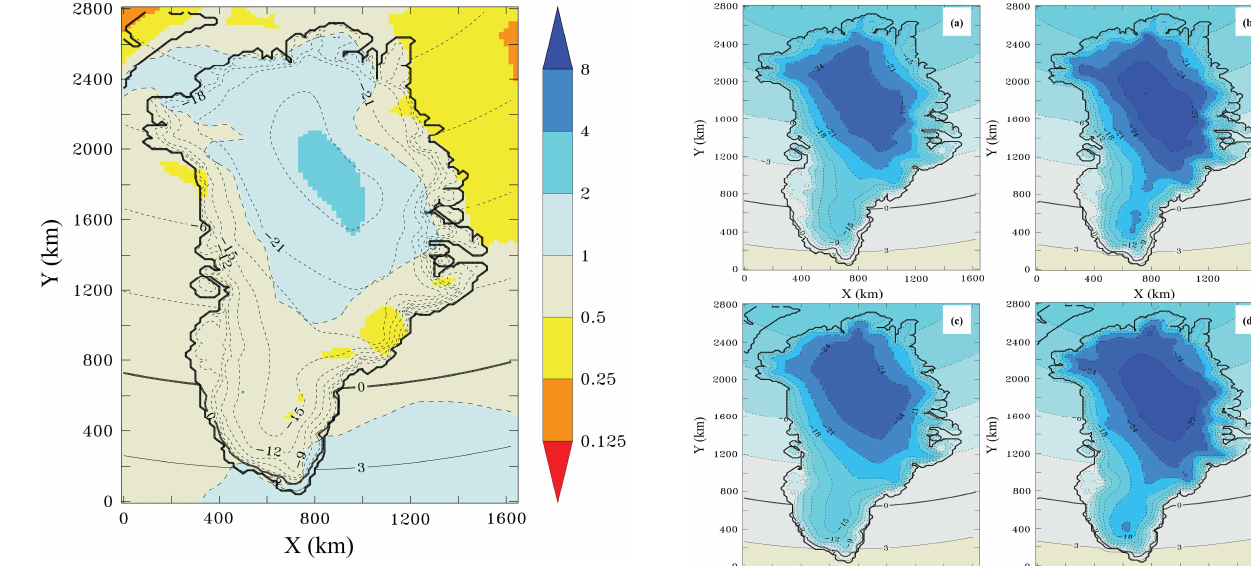
Figure 3. Change in precipitation over Greenland between EISMINT-3 (Ohmura and 2 Fig. 3. Change in precipitation over Greenland between EISMINT- Reeh, 1991) and ERA-40 re-analysis (Uppala et al. 2005) expressed as a ratio of 3 3 (Ohmura and Reeh, 1991) and ERA-40 re-analysis (Uppala et EISMINT-3:ERA-40. Annual near-surface temperature (in °C) contours also shown 4 al., 2005) expressed as a ratio of EISMINT-3:ERA-40. Annual near-surface temperature (in ◦ C) contours are also shown (Ohmura, (Ohmura, 1987). 5 1987).